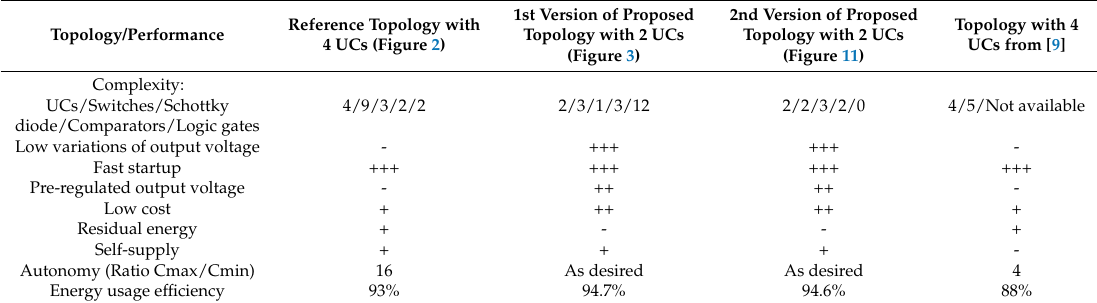
Table 3. Comparison of the proposed adaptive storage to previously published